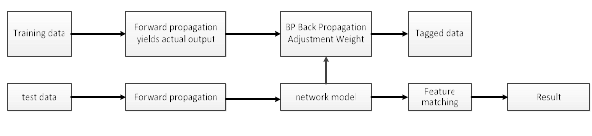
Figure 2. CNN processing flow